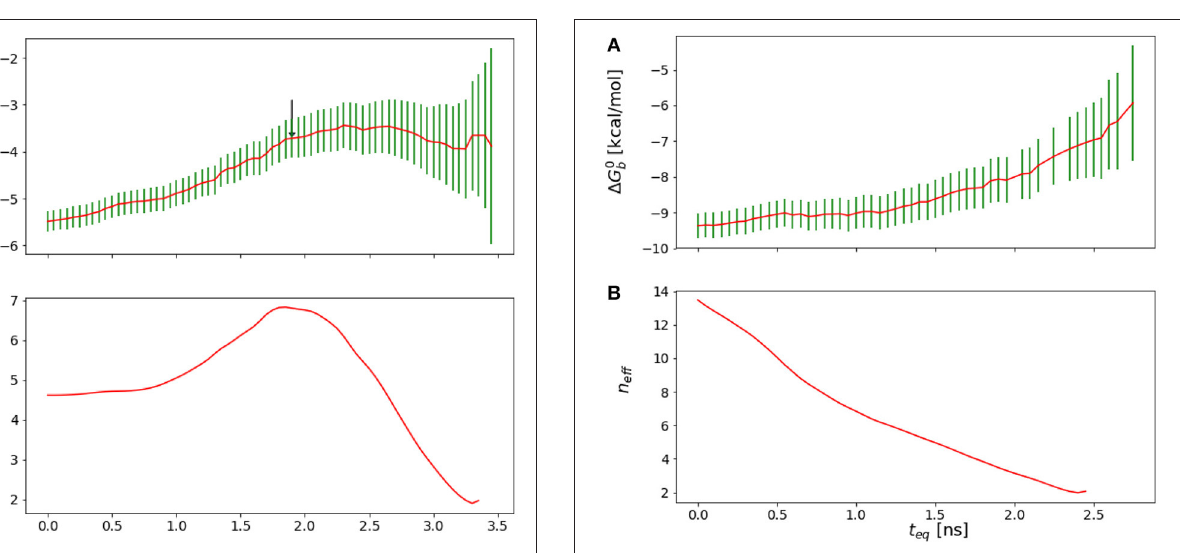
FIGURE 4 | (A) Reverse cumulative convergence plot and (A) corresponding n eff plot for the binding free energy of the complex of HIV integrase with the SLKIDNLD linear peptide. Both figures show that neither a qualitative (A) nor a quantitative approach (B) provides a valid equilibration time for this system. The conclusion is that the binding free energy for this system has not reached